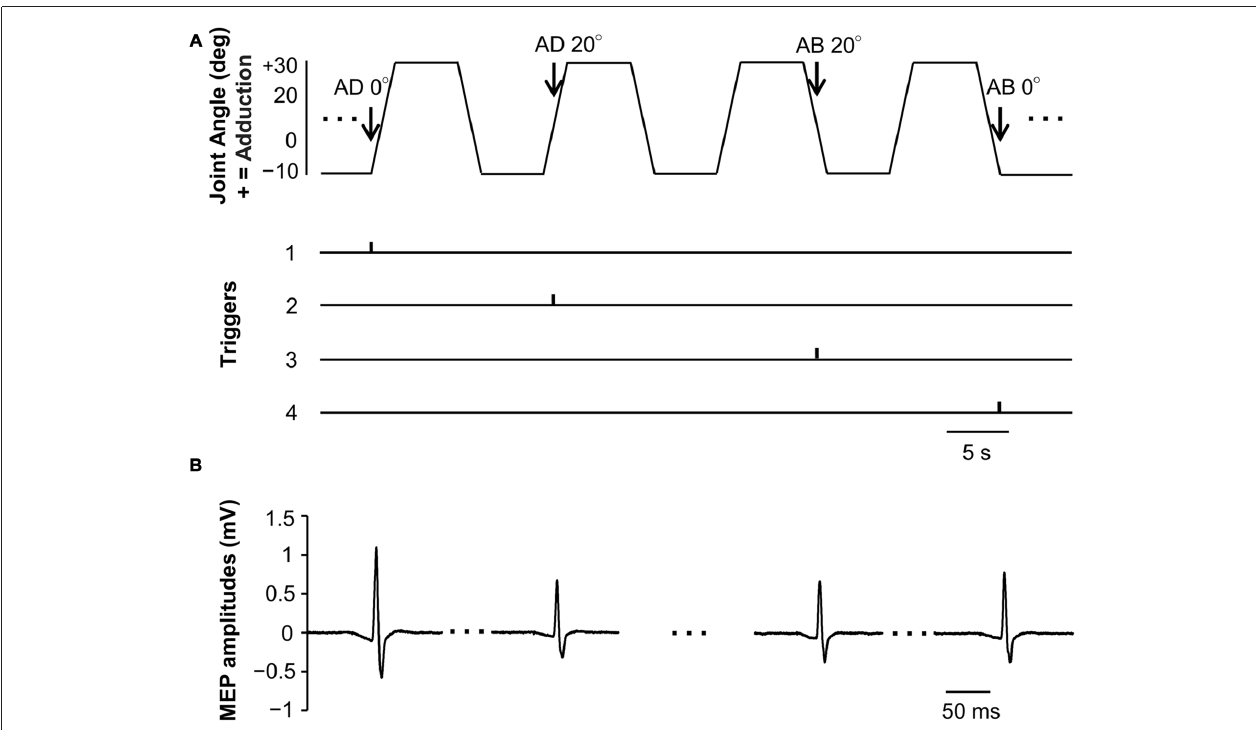
FIGURE 3 | Joint angle, trigger signals and MEP waveforms elicited by one representative subject during passive movement in Experiment 1. (A) Abduction-adduction joint angle and output trigger signals for transcranial magnetic stimulation (TMS) during passive movement. Triggers 1, 0 ◦ joint angle during passive adduction (AD 0 ◦ ); Trigger 2, 20 ◦ adduction during passive adduction (AD 20 ◦ ); Trigger 3, 20 ◦ adduction during passive abduction (AB 20 ◦ ); Trigger 4, 0 ◦ joint angle during passive abduction (AB 0 ◦ ). (B) MEP waveforms elicited at each joint angle during passive movement.